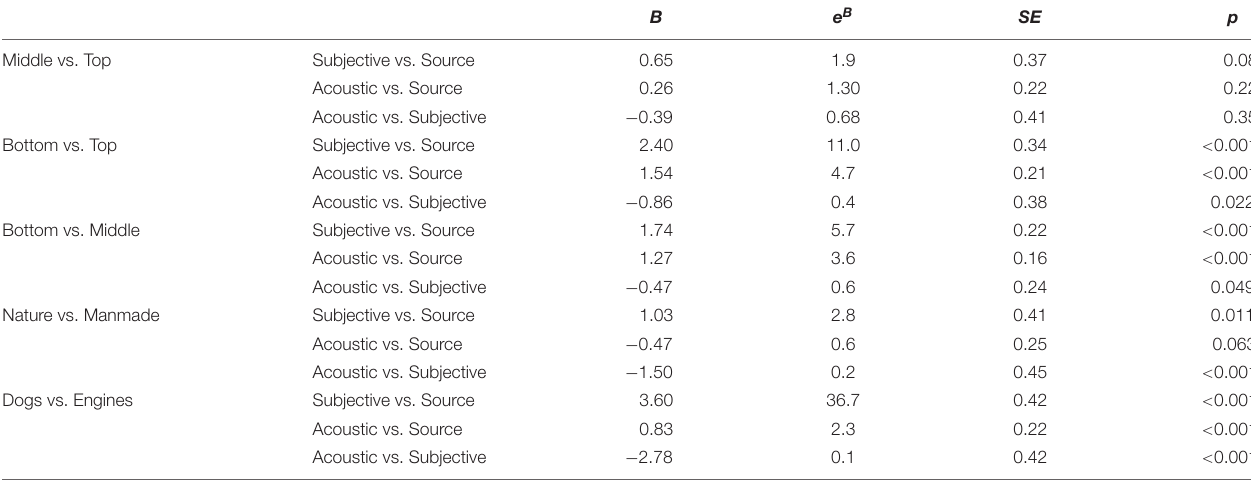
TABLE 4 | Results of the multinomial logit regression models.